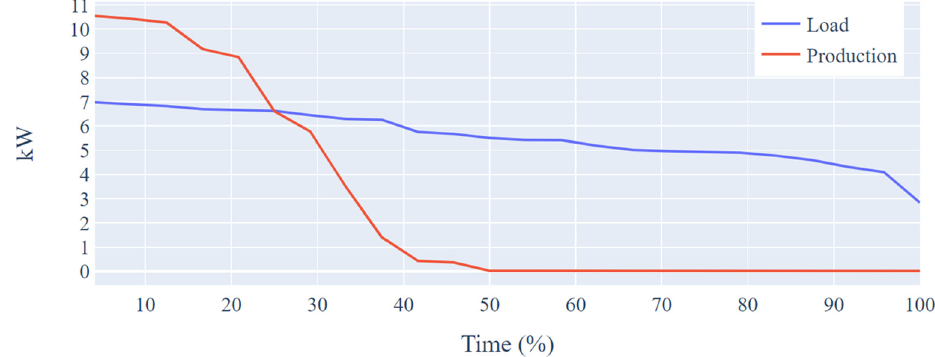
Figure 4. Duration curves for the period in consideration—computed on average yearly data.